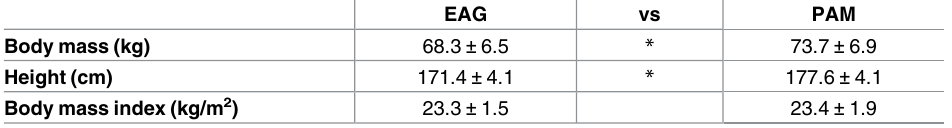
Table 1. Physical characteristics of the elite artistic gymnasts (EAG) and physically active men (PAM) in mean and standard deviation